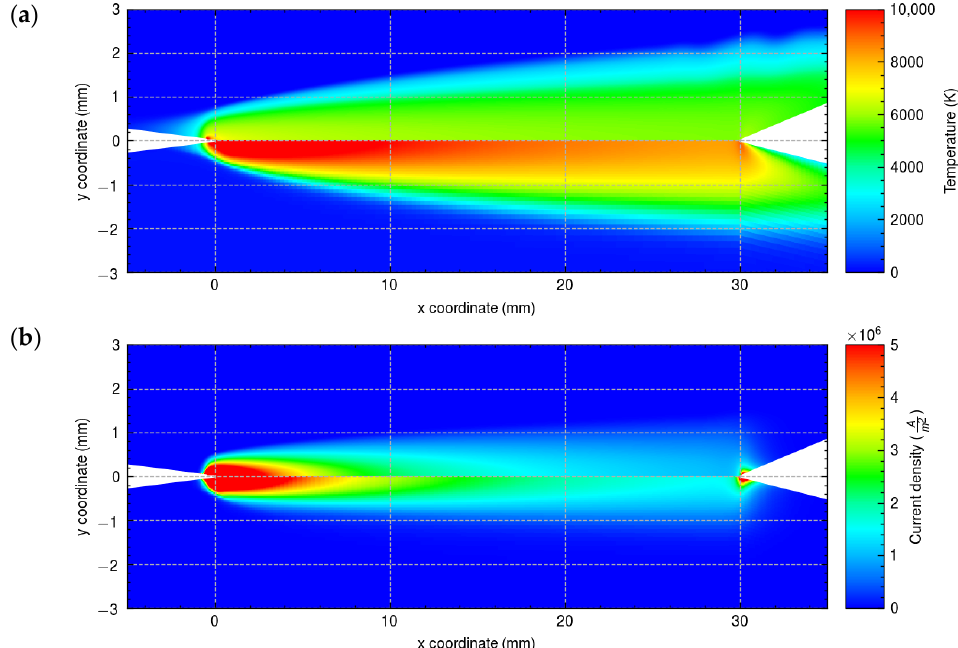
Figure 10. The 2D distribution of temperature ( a ) and current density ( b ) at I = 5 A obtained in FlowVision (top) and Plasmaero (bottom).